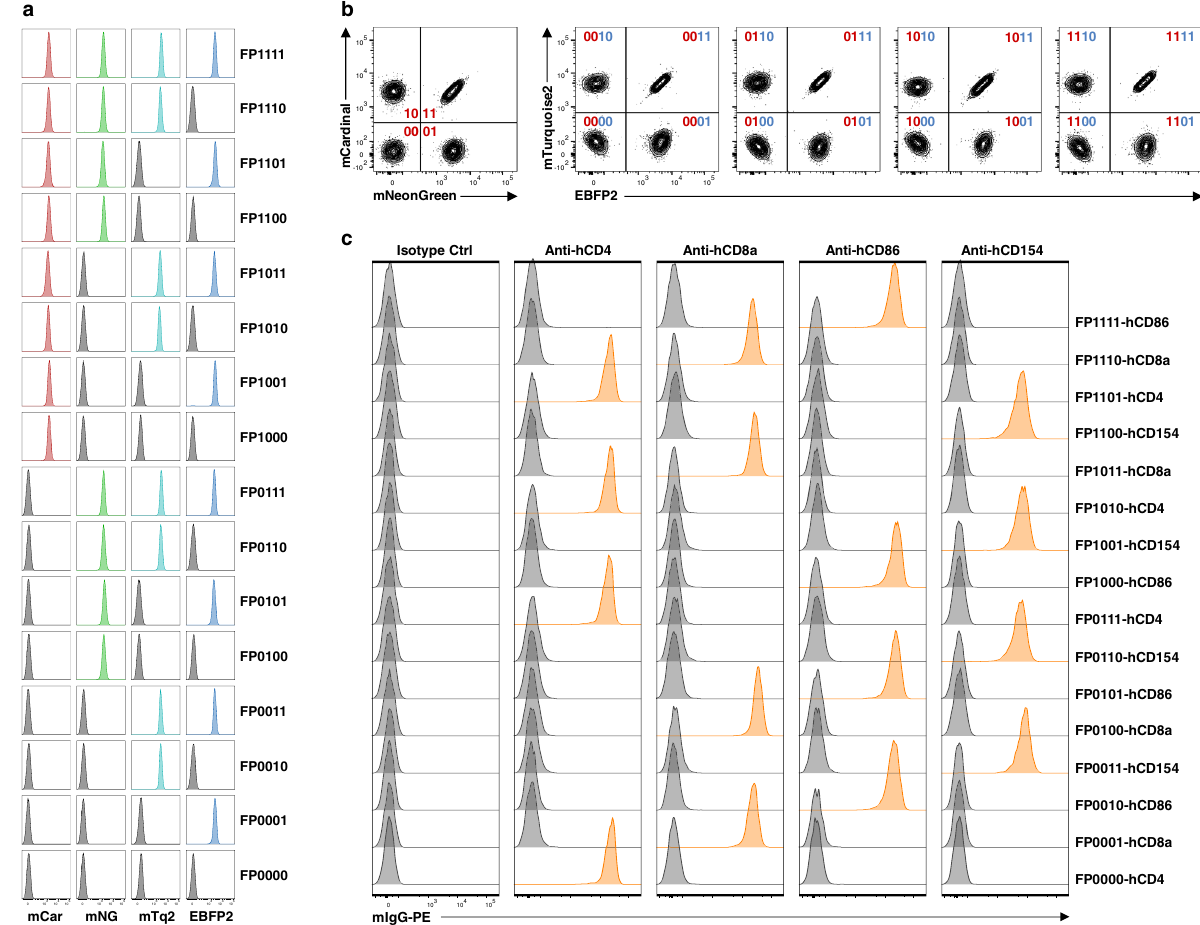
Fig. 1 A multiplex immunoassay based on FP-barcoded reporter cell lines. a A basic panel of FP-barcoded reporter cell lines. K530 cells were transduced with different combinations of 4 FPs to produce 16 uniquely FP-barcoded reporter cell lines. The absence/presence of fl uorescence from FPs EBFP2, mTurquoise2 (mTq2), mNeonGreen (mNG), and mCardinal (mCar) are designated as four digits of binary barcodes as shown on the right of histograms for each individual cell line. b Demultiplexing of pooled FP-barcoded reporter cell lines by fl ow cytometry. c The 16 barcoded reporter cell lines were transduced to express human CD4, CD8a, CD86, and CD154 molecules in a shifted pattern relative to FP expression. These cells were pooled and stained with corresponding mouse monoclonal antibodies (as indicated on the top of each histogram) followed by a PE-conjugated anti-mouse IgG antibody. Signals from individual reporter cell lines were demultiplexed as shown in b and the binding by corresponding antibodies were plotted as half-offset histograms. In all cases, the detected expression patterns were consistent with antigen expression by barcoded cells before multiplexing as shown on the right of histograms for each individual cell line. Isotype Ctrl, mouse IgG1, κ -isotype control antibody. Data from one experiment are shown. Data from another independent repeat experiment are shown in Supplementary Fig.